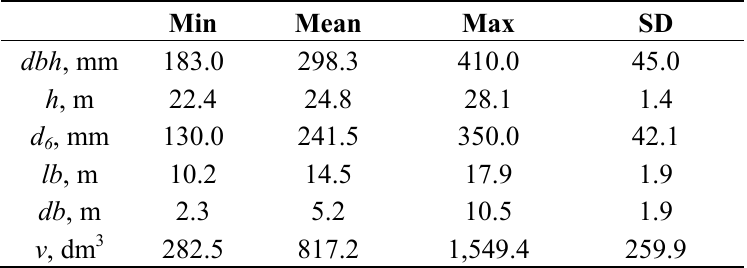
), height of the lowest living ( lb ) 6